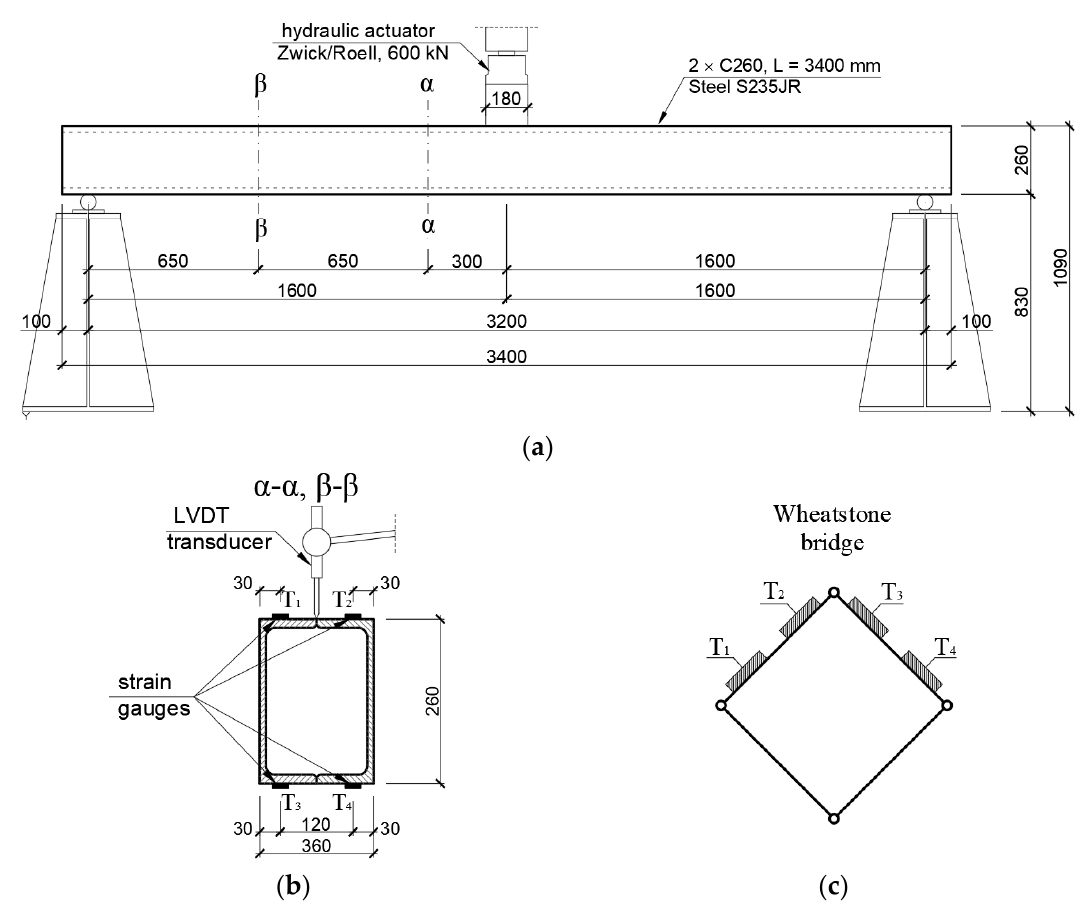
Figure 1. Scheme of the test stand: ( a ) view of the tested beam; ( b ) location of measurement sensors in the cross ‐ section; ( c ) location of strain gauges in the Wheatstone bridge.